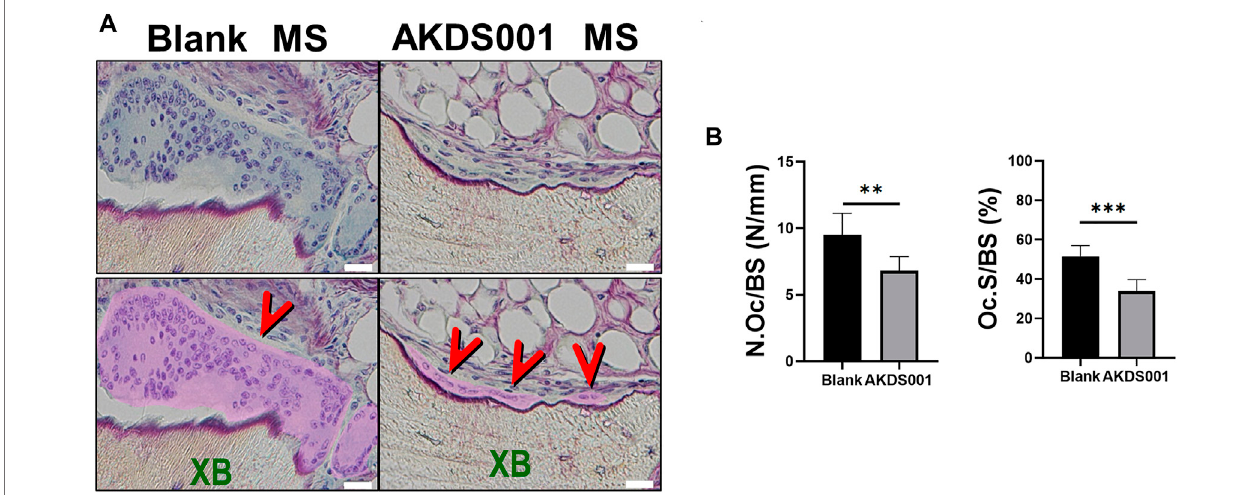
FIGURE 5 | Histomorphometric analysis of Blank MS versus AKDS001 MS (1.0 mg/ml) on the surface of xenografted bone. (A) Representative Villanueva bone stainingofxenografted bone.XB, xenografted bone. Scale bars,20 μ m. Osteoclastareais fi lled with pinkand pointed by red arrows. (B) Number ofosteoclasts (N.Oc)/ BSandosteoclastsurface(Oc.S)/BS onxenograftedbone.BlankMS, n =6;AKDS001MS, n =6.Datarepresentthemean±SD(errorbars).** p < 0.01,*** p < 0.001by two-tailed Student ’ s t -test